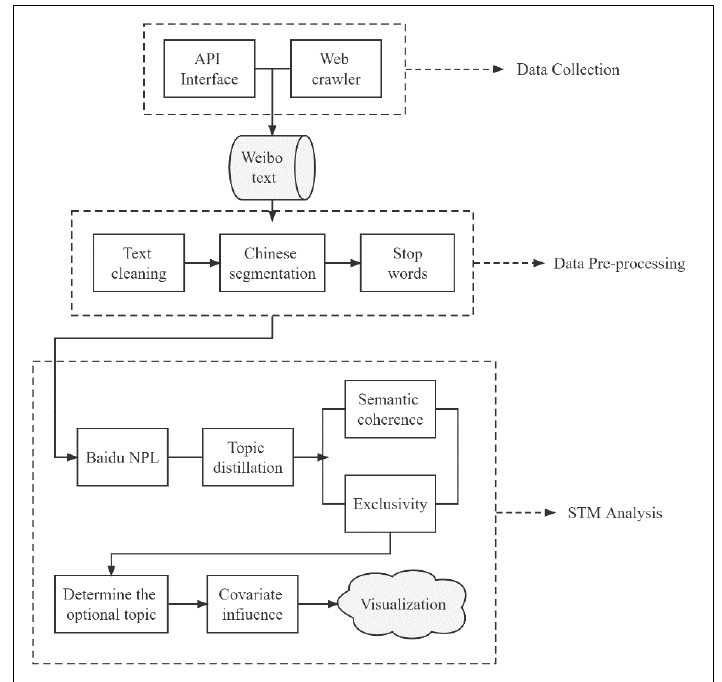
Figure 1. Framework of the data analysis process.